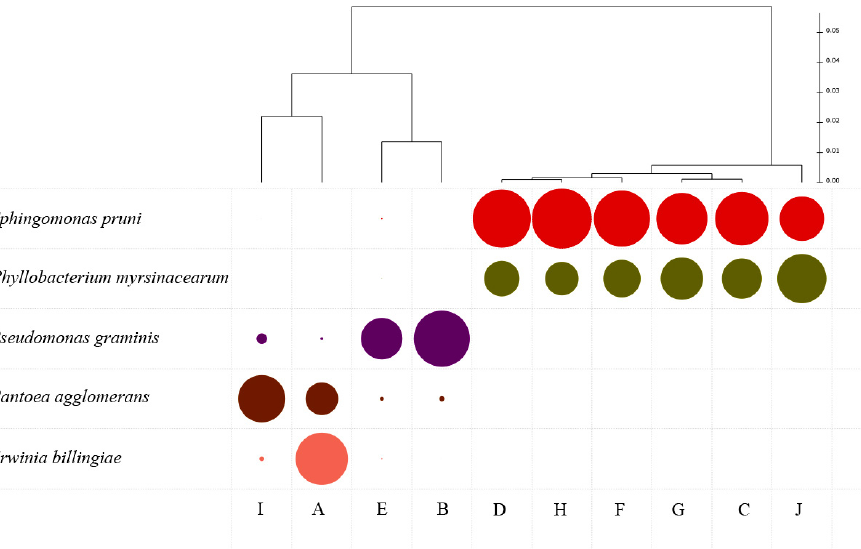
Figure 6. Clustering dendrogram considering the most dominant bacterial groups present in the different plots (A–J), and size of colored circles reflecting relative abundance of each taxon.